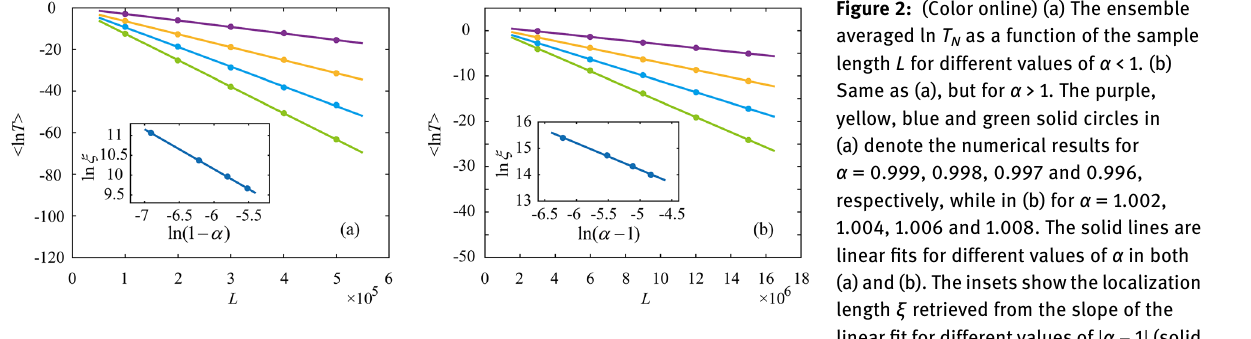
circles)forboth α <1[insetin(a)]and α >1[insetin(b)]cases.Allnumericalresultsintheinsetsarewell fi ttedbyarelation ξ ∝ | α − 1 | v with v =1 for both α < 1 and α > 1.